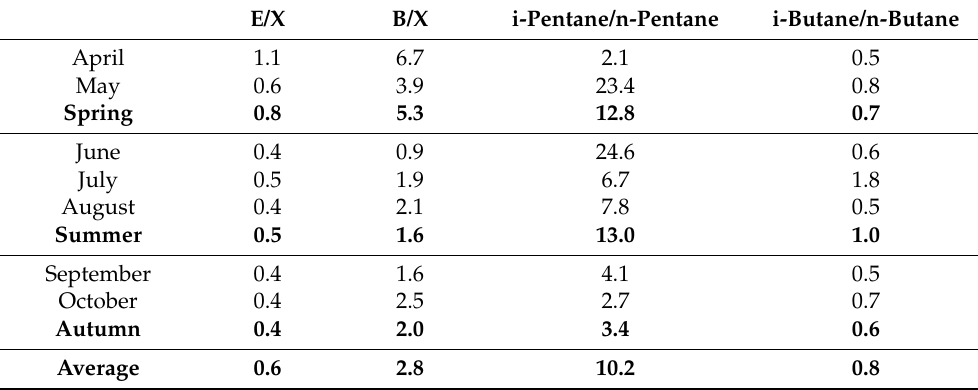
Table 1. Ratio of selected VOC species in